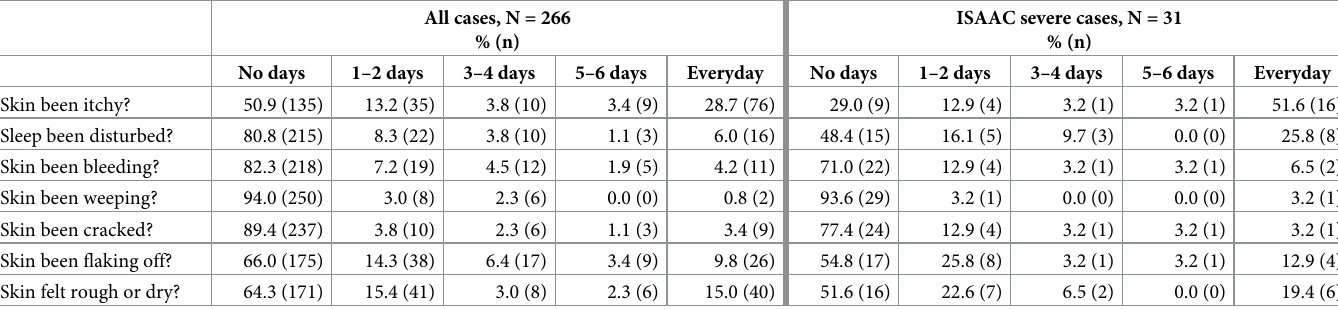
Table 3. Components of POEM severity measure a